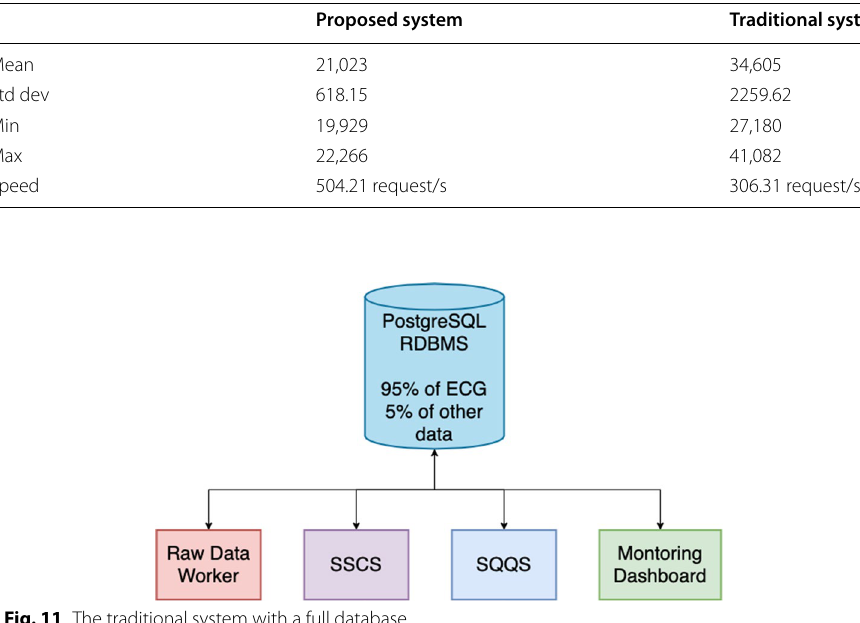
Table 4 Database read evaluation summary